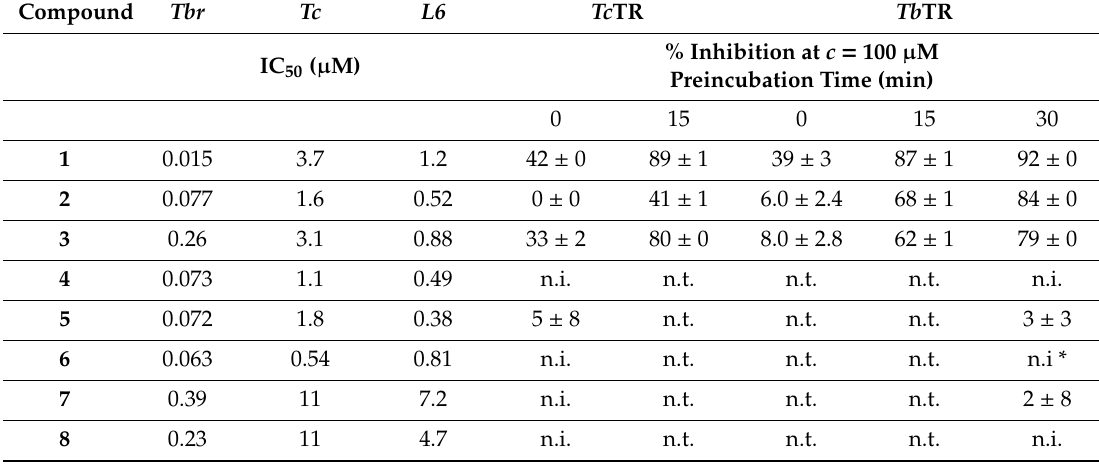
Table 1. In vitro activity of selected STLs (structures see Figure 1) against recombinant trypanothione reductase from both T. brucei ( Tc TR) and T. cruzi ( Tb TR). In vitro activity data against T. brucei rhodesiense (Tbr) , T. cruzi (Tc) , and L6 rat skeletal myoblasts are from our previous reports [1,2,5] and repeated here for easier comparison. Enzyme inhibition data represent mean % inhibition at 100 µ M ± SD ( n ≥ 2).